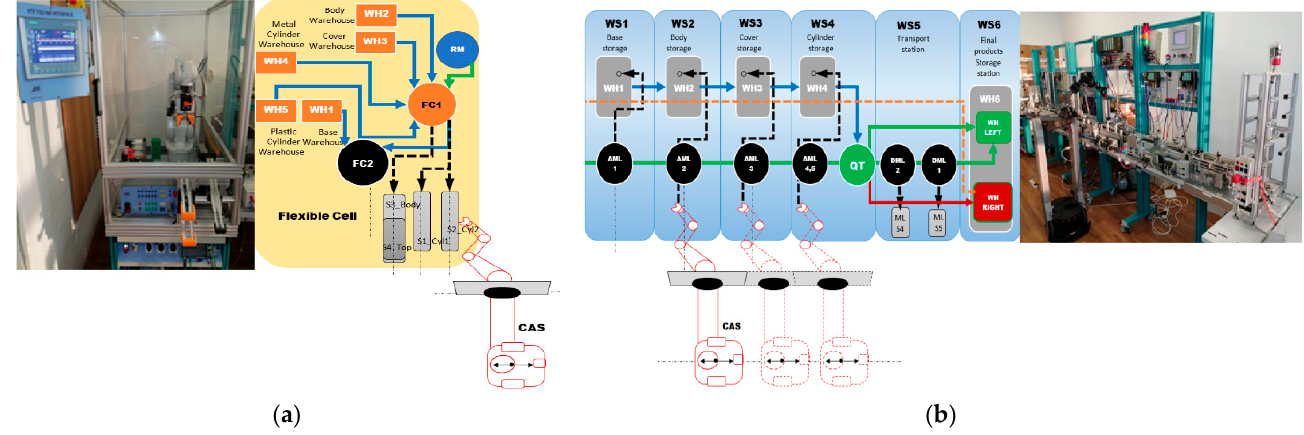
Figure 2. A/D/RML assisted by CAS: ( a ) Flexible cell station with 6-DOF ABB IRB120; ( b ) A/DML Hera & Horstmann.